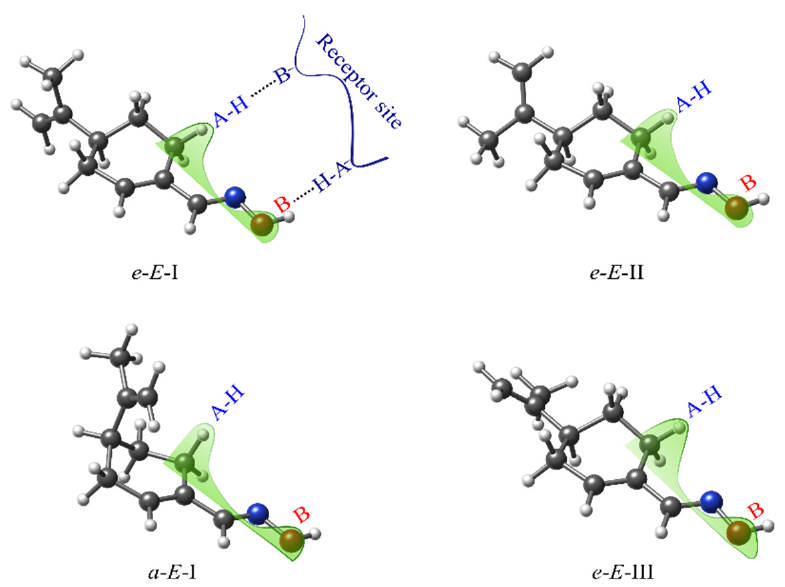
Figure 3. Calculated structures for the four detected conformers of perillartine. The AH-B (CH-O) distance is 4.3 Å for all the structures.